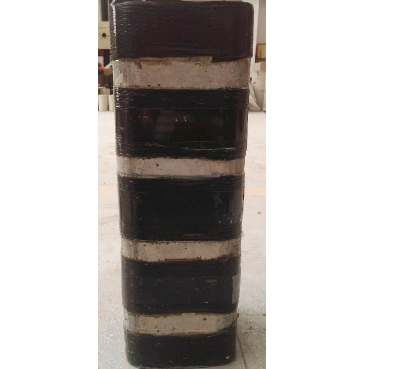
Figure 1. Schematic of the fiber-reinforced polymer (FRP) partial wrapping strengthening technique.